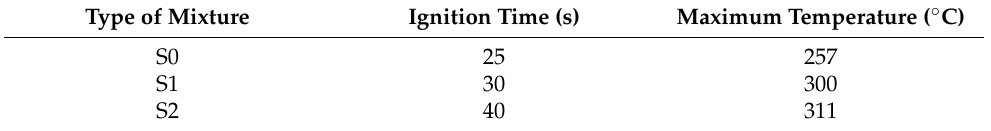
Figure 12. Change in the temperature of different asphalt concrete with time. Table 8. Duration of ignition and ignition temperature of different samples.